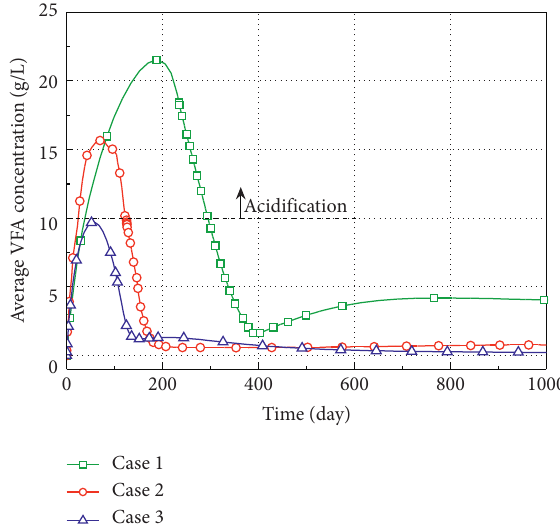
Figure 3: VFA concentration in leachate collected at the bottom under different recirculation conditions.